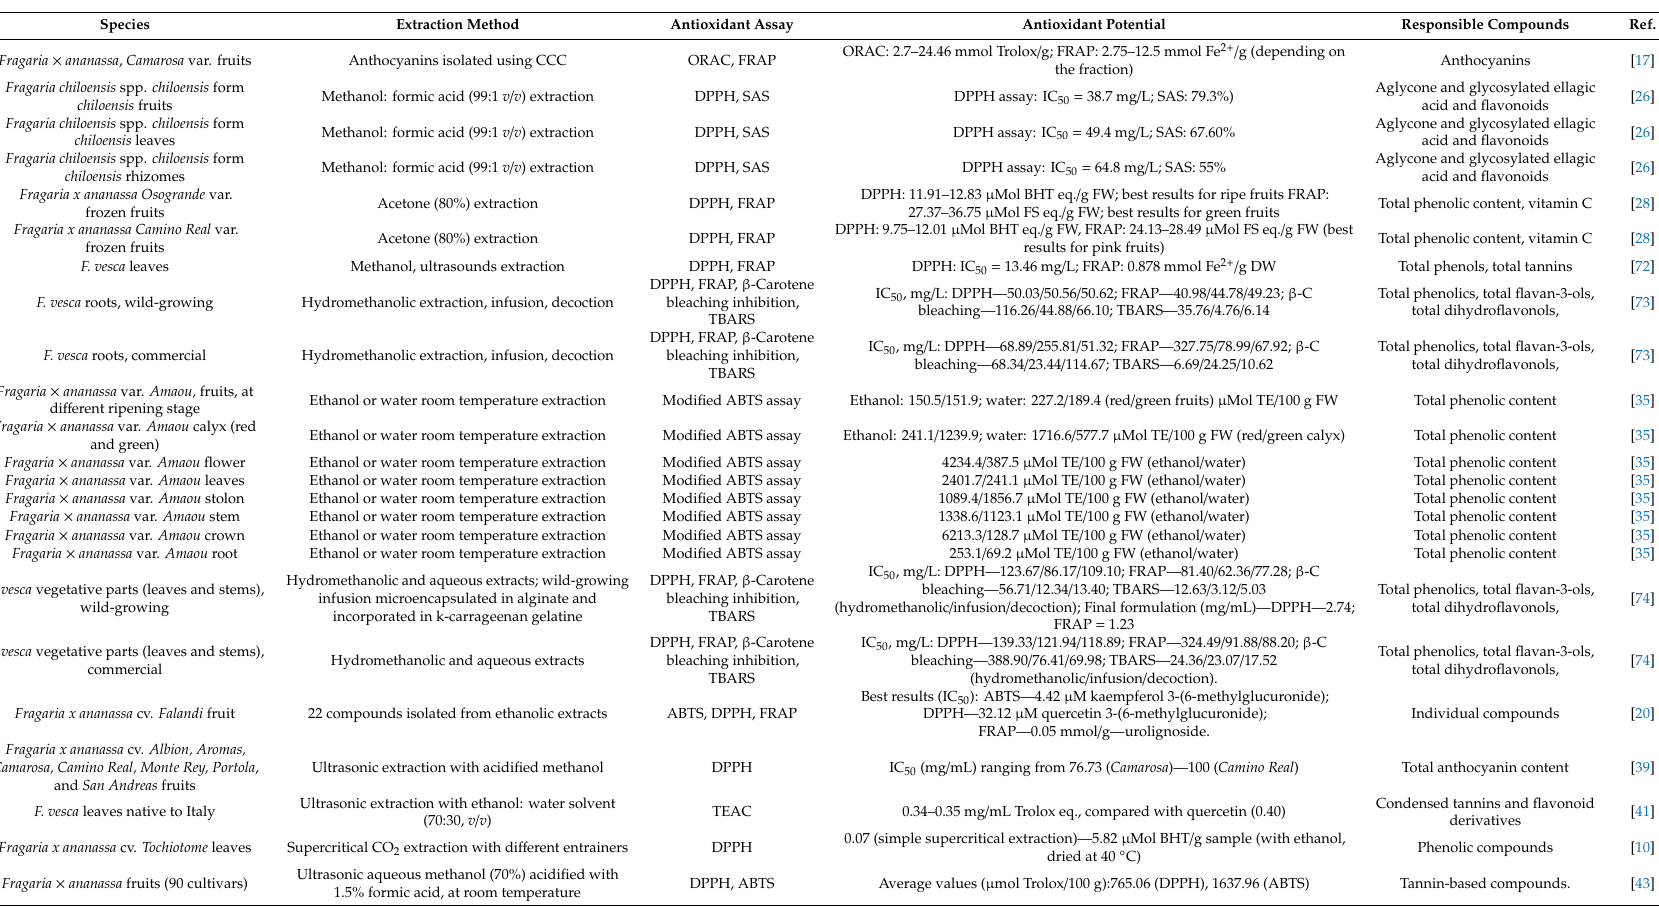
Table 3. Antioxidant properties of di ff erent extracts obtained from Fragaria species (references presented in chronological order). Species